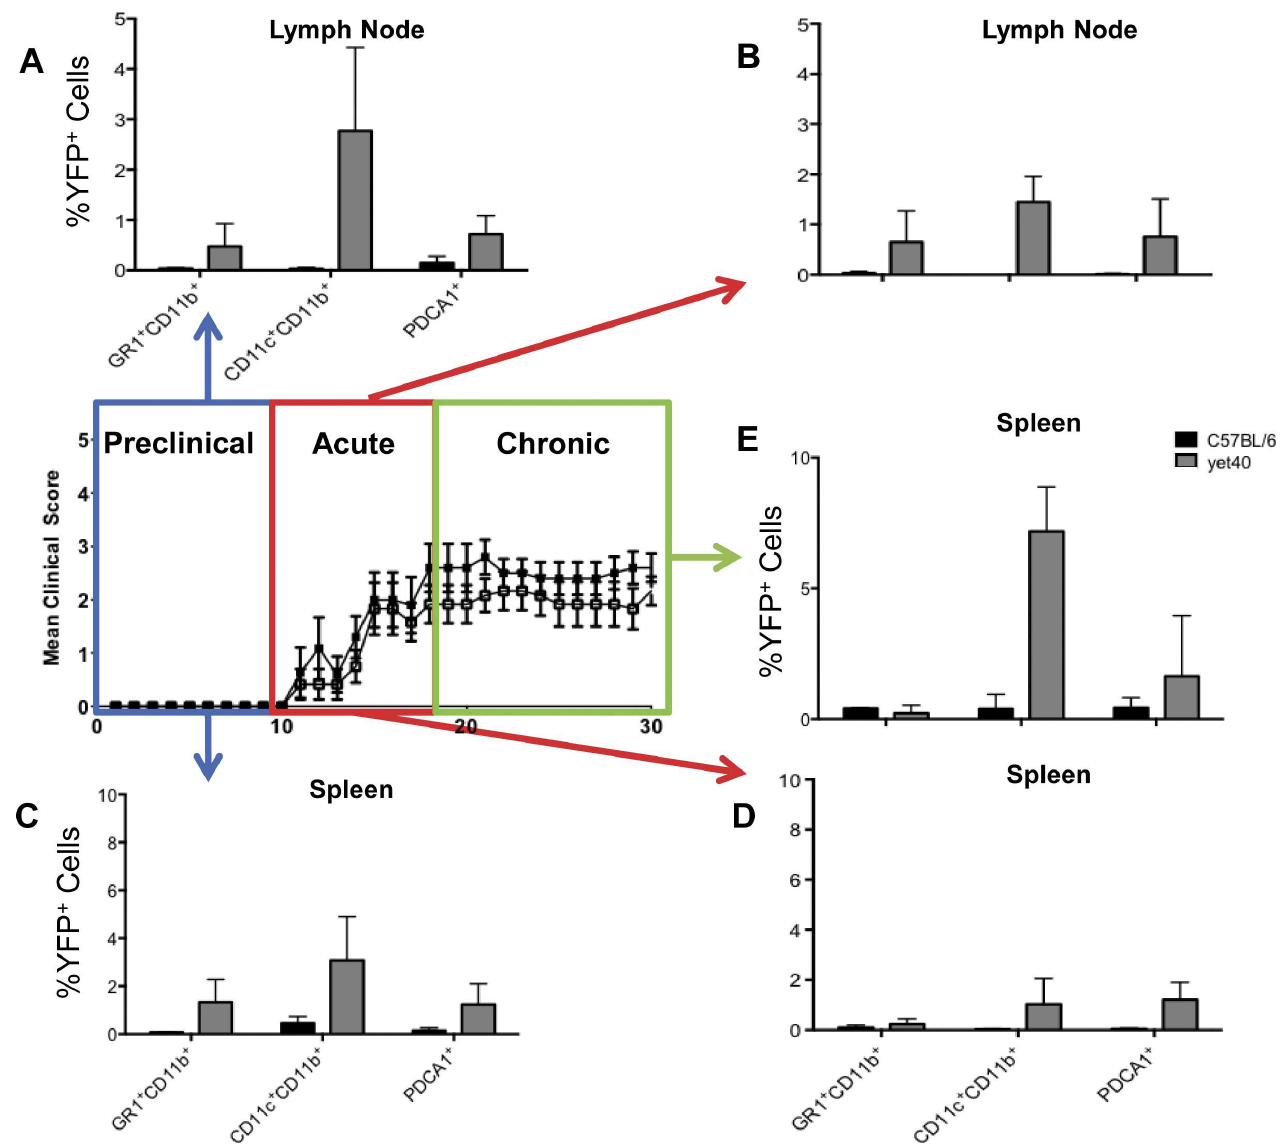
Fig 2. P40 is highly expressedin secondary lymphoid organs during experimental autoimmune encephalitis (EAE). To investigate which APCs could express IL12/23p40during the course of EAE, we examinedAPC subsets from B6.129-Il12b strain of p40eYFP reporter mice (yet40 mice) for expression of eYFP by multi-parameter flow cytometry. Splenocytes were assessed during the pre-clinical, acute, and chronic stages of EAE (please see the Material and Methods section for definitionsof disease stages). In lymph nodes cells, p40 expression was only assessed during the inductionand acute disease stages, as p40 was undetectable during the chronic disease stage in this EAE model (data not shown). (A & B) p40 eYFP expressionwas readily detectableby flow cytometry in lymph node cells, and (C-E) splenocytes from yet40, but not in control C57BL/6 mice during the pre-clinical,acute, and chronic EAE stages. (A-E) During most disease stages in both compartments, CD11c + Cd11b + dendritic cells (DC) were the main expressers of p40-eYFP, followedby PDCA1 + plasmacytoid dendritic cells (pDCs), and GR1 + CD11b + immature myeloid